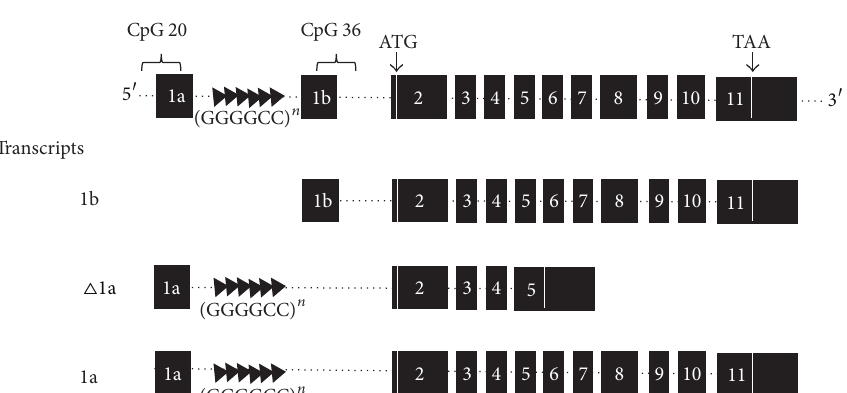
Figure 1: Structure of the C9orf72 locus and its three primary transcripts. Two alternative first exons are used, 1a and 1b, and both of these lie upstream of the translation start site. Between exons 1a and 1b lies the hexanucleotide expansion region. Note that two putative CpG islands lie either side of the expansion. The shorter of these regions, CpG 20, overlaps with much of the sequence of exon 1a. Although there are three transcripts, the position of the ATG start codon in exon 2 means that only two protein isoforms are translated: isoform A is 481 amino acids long, while the shorter isoform B is only 222 amino acids in